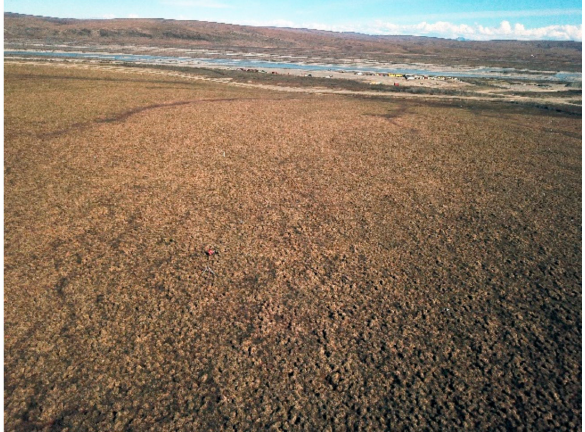
Figure A4. Oblique aerial photo of HV on 30 May 2019.